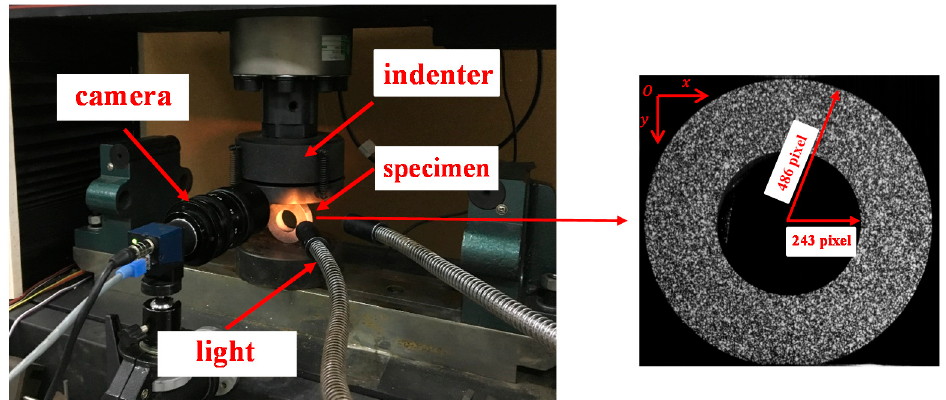
Figure 11. Experimental setup of diametrical compression test.